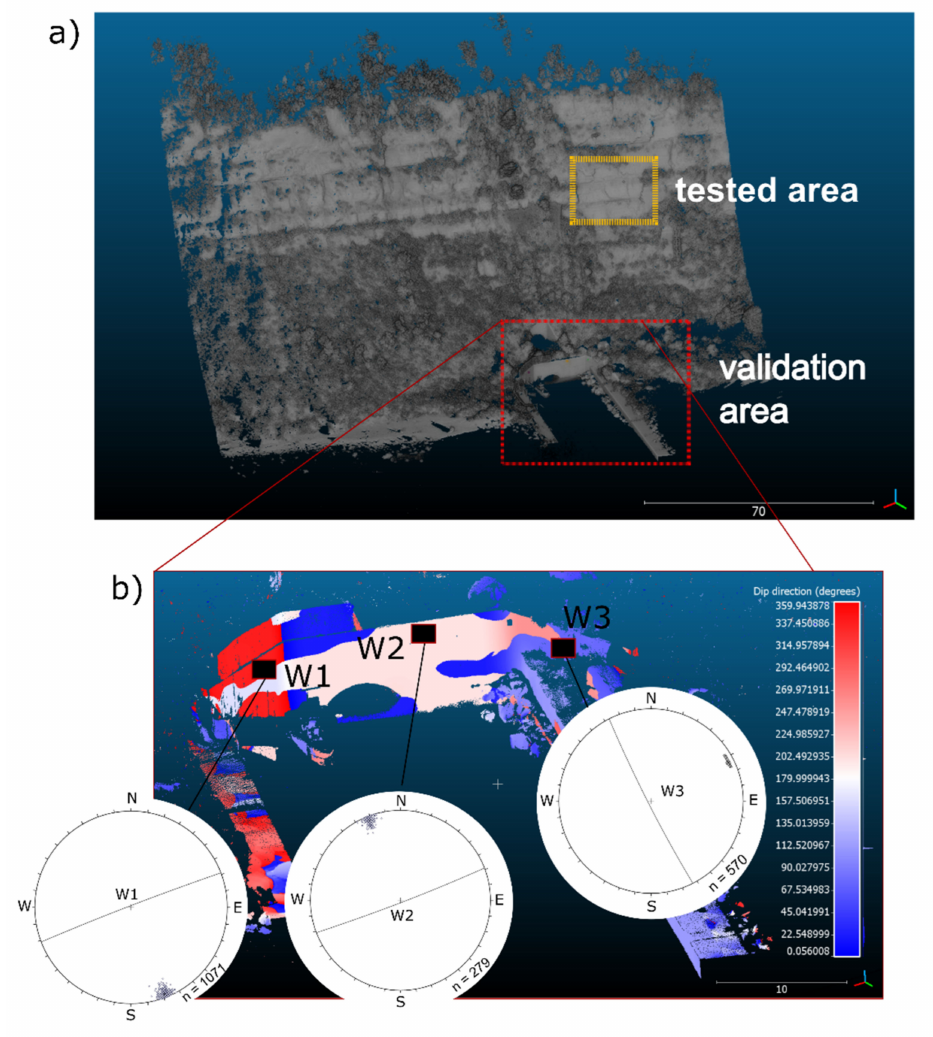
Figure 11. Validation of the procedure for discontinuity clusters identification. ( a ) position of the tested and the validation areas; ( b ) Location of the three selected portions of the retaining wall located at the top of the cliff examined, and identified with W1, W2 and W3.